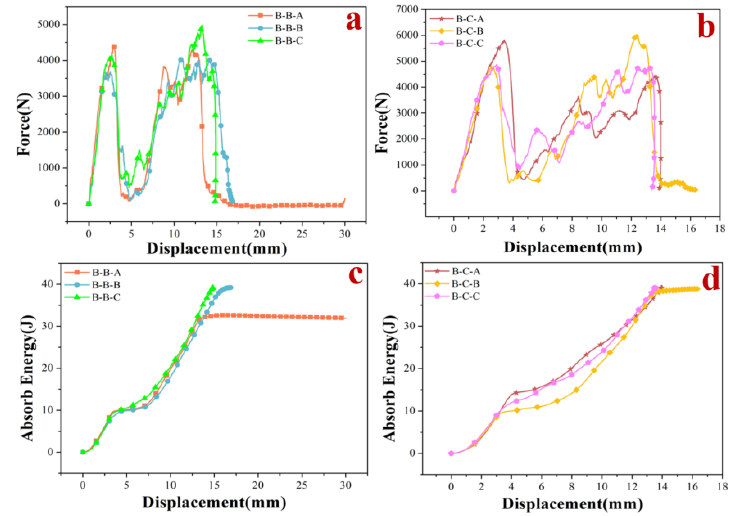
Figure 6. ( a ) Core B group stress–displacement curve. ( b ) Core C group stress–displacement curve. ( c ) Core B group absorbed energy–displacement curve. ( d ) Core C group absorbed energy–displacement curve.